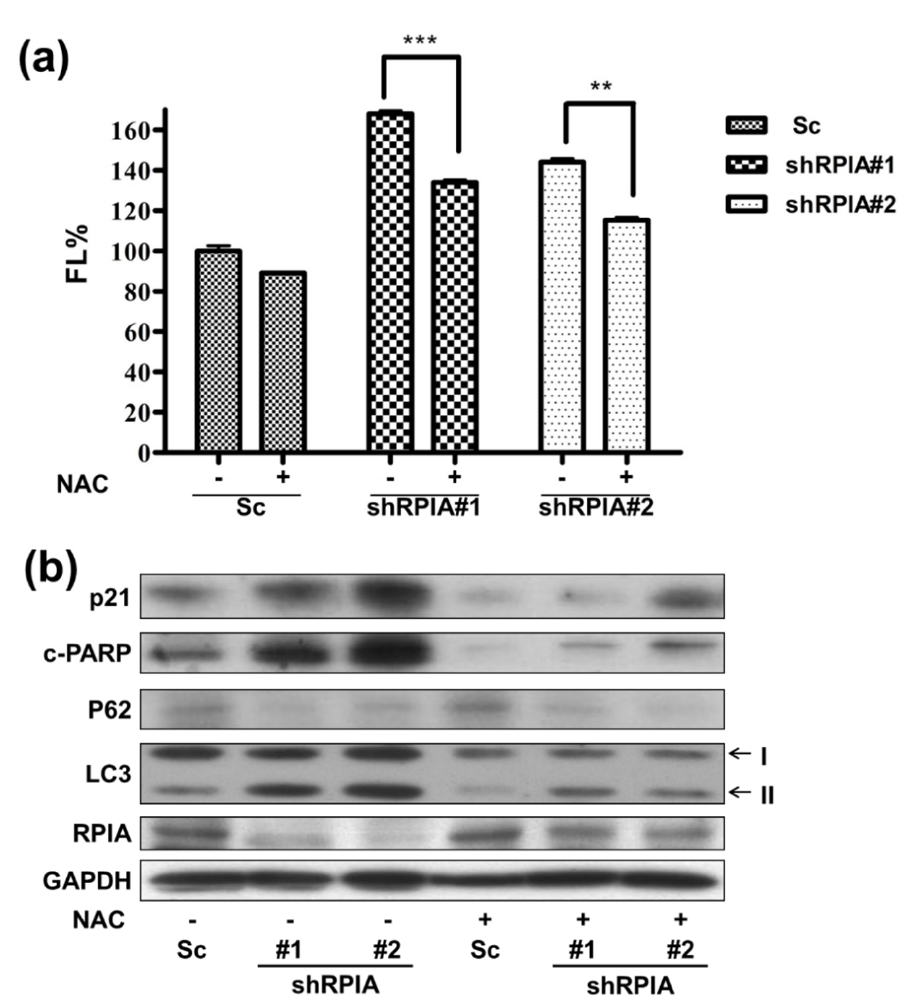
Figure 8. Reactive oxygen species (ROS) induced by RPIA knockdown lead to autophagy and apoptosis in lung cancer cells. ( a ) Treatment of ROS scavenger N-acetyl-L-cysteine (NAC) 10 mM in shRPIA-A549 cells were performed for one hour and the cells were stained with oxidized DCFDA, and then analyzed by flow cytometry. Knockdown of RPIA increased ROS generation. After treatment of NAC, shRPIA-A549 cells decreased ROS generation. FL% (DCF fluorescence). Statistical analyses were performed by Student t -test, ** p < 0.01, *** p < 0.001. ( b ) Knockdown of RPIA induced apoptosis, enhanced cleaved PARP (c-PARP), activated autophagy (up-regulated LC3-II, down-regulated p62) and cellular senescence (increased of p21) measured by using Western blot. After treating cells with ROS scavenger N-acetyl-L-cysteine (NAC) for 1 h, the knockdown of RPIA decreased autophagy and apoptosis protein marker expression in A549